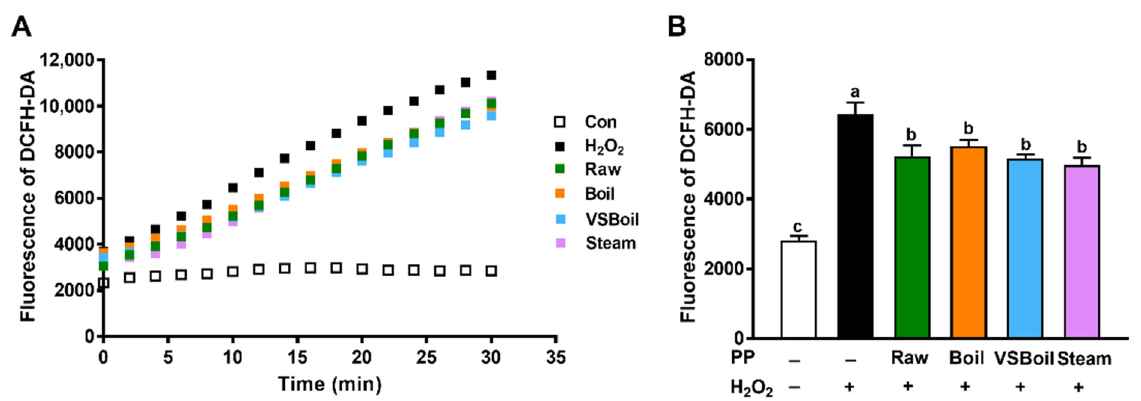
Figure 4. Effects of purple potato (PP) extracts on intracellular reactive oxygen species (ROS) production in human colonic Caco-2 cells induced by H 2 O 2 . ( A ) Intracellular ROS production was detected with DCFH-DA in Caco-2 cells pre-treated with PP extracts and followed by H 2 O 2 induction for 30 min. ( B ) Intracellular ROS production in Caco-2 cells treated with PP extracts and H 2 O 2 at 10 min. VSBoil: Vacuum-seal boiling. a–c means among bars without common letters differ significantly at p < 0.05 (mean ± SEM, n = 8).